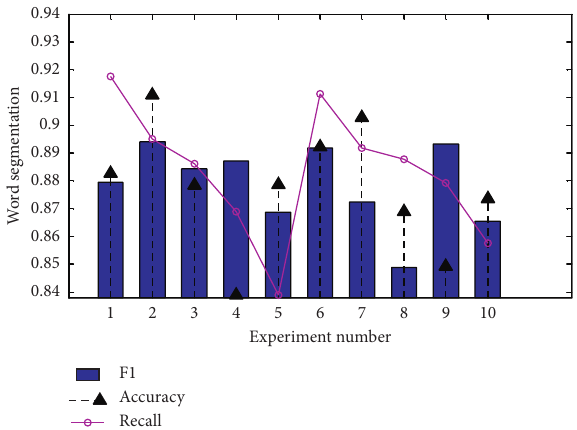
Figure 8: Various word segmentation results of Fish with OOV.